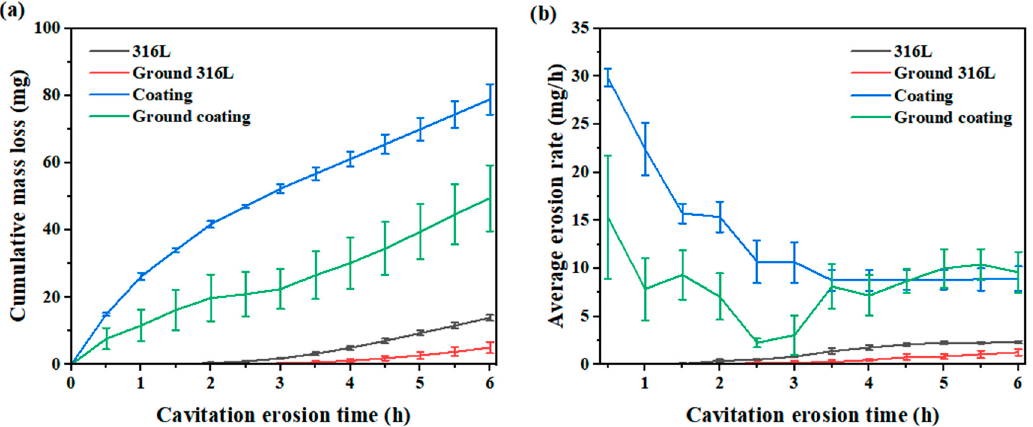
Figure 4. Cumulative mass losses ( a ) and average erosion rates ( b ) of the specimens after cavitation erosion exposure for 6 h in deionized water.